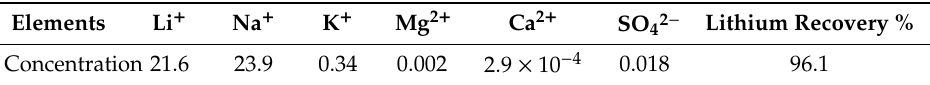
Table 7. The composition of the solution after magnesium removal (g·L − 1 ).